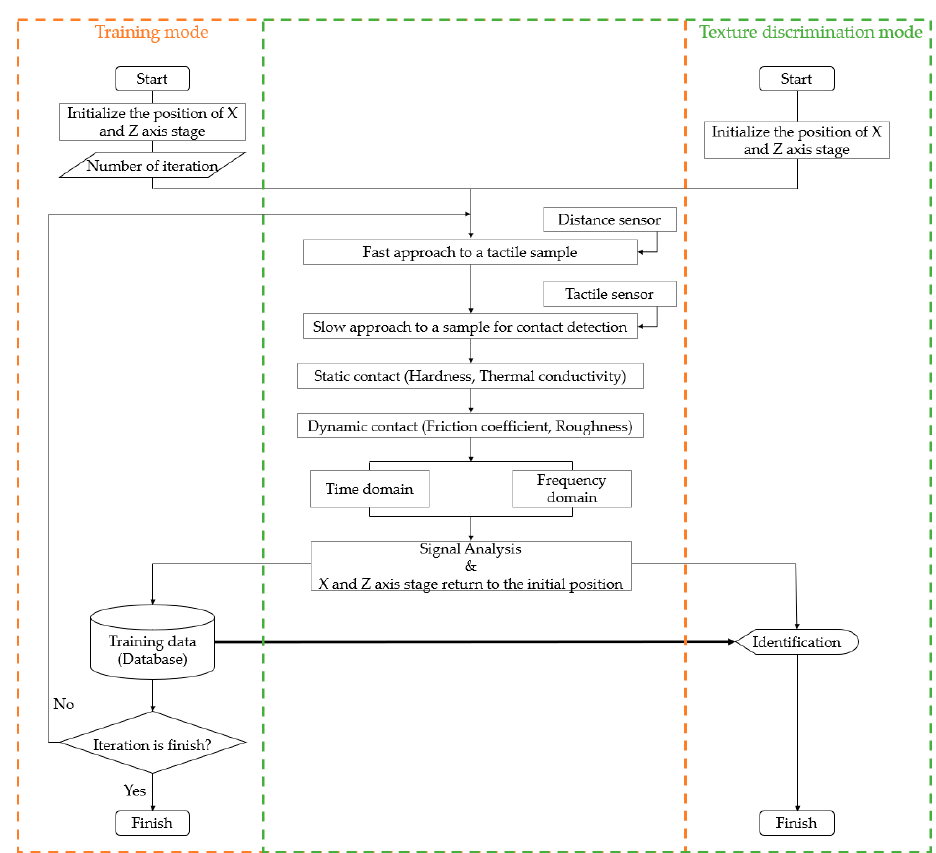
Figure 4. The flow chart for operating the motorized texture discrimination platform.